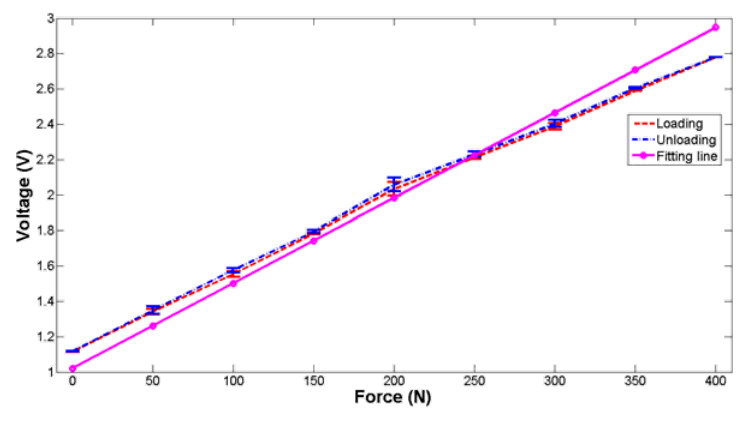
Figure 12. The static performance of the designed plantar force